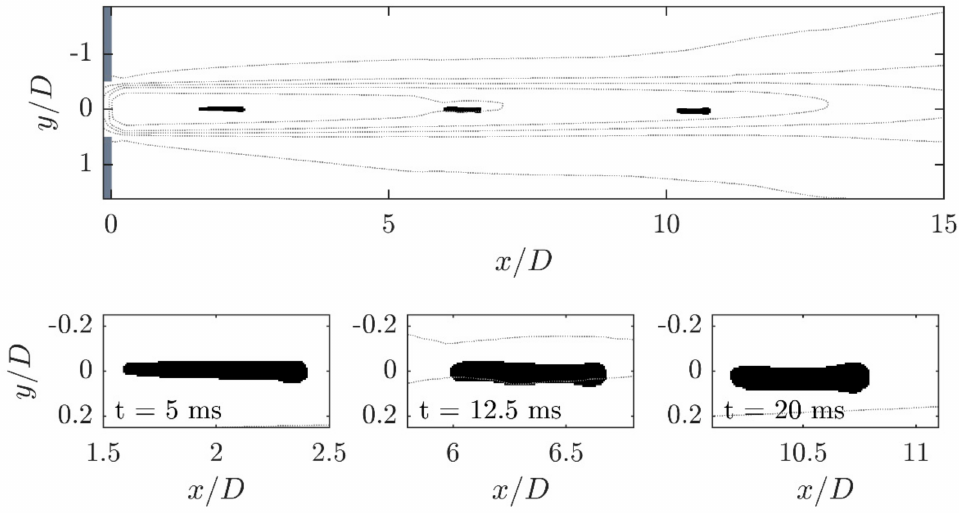
Figure 7. Visualization of the droplet relaxation at different locations within the core area of the free